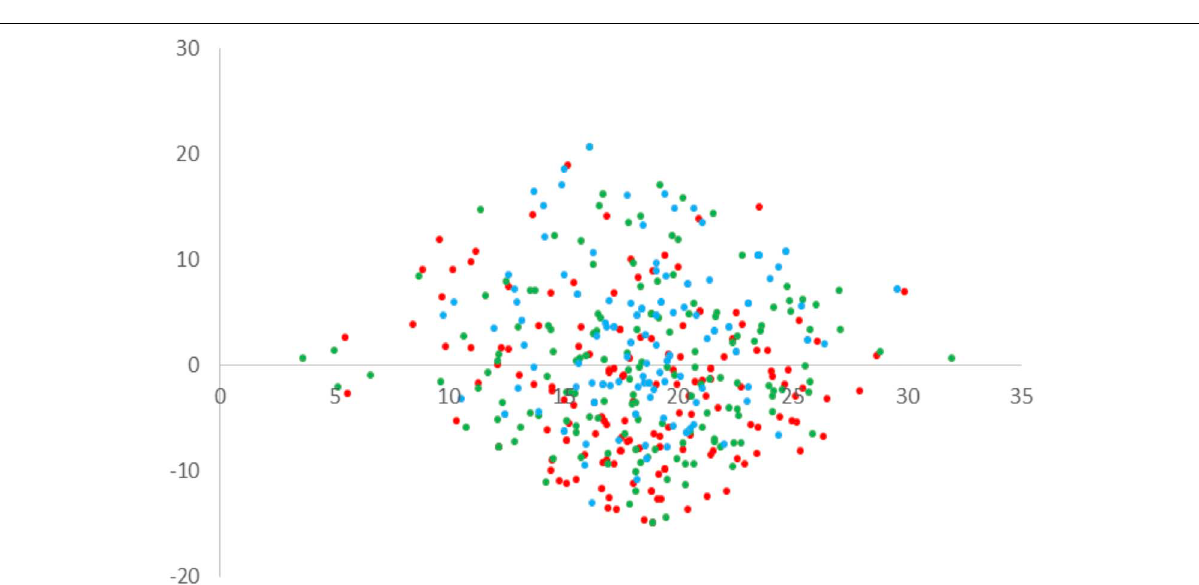
FIGURE 4 | Results of the PCA on emotions of K-8 to K-10 students toward the learning of Physics and Chemistry: scores plot for PC1 and PC2 (red points: K-8; green points: K-9; blue points: